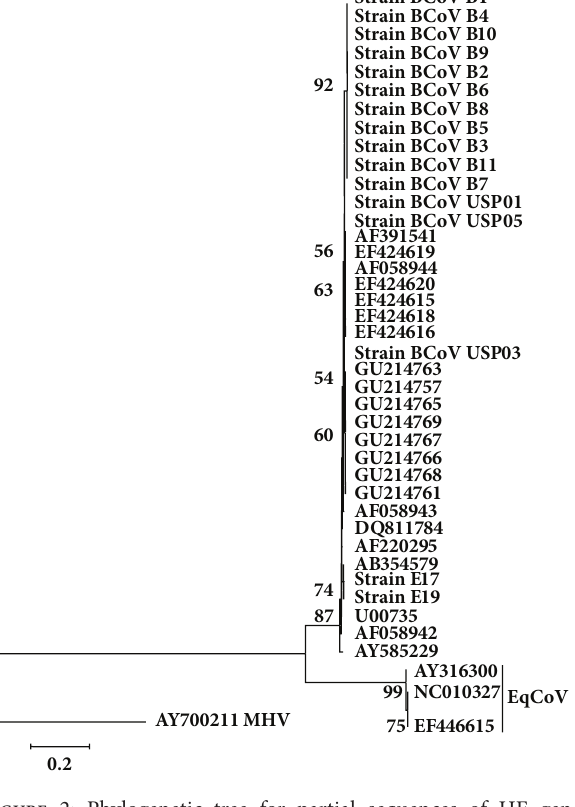
Figure 2: Phylogenetic tree for partial sequences of HE gene (nucleotides 189 to 521 of Mebus strain GenBank accession number U00735.2). Strains of the present study are in bold. The numbers at each node are the bootstrap values obtained with 1,000 replicates (only values > 50 are shown). The bar represents the number of substitutions per site.